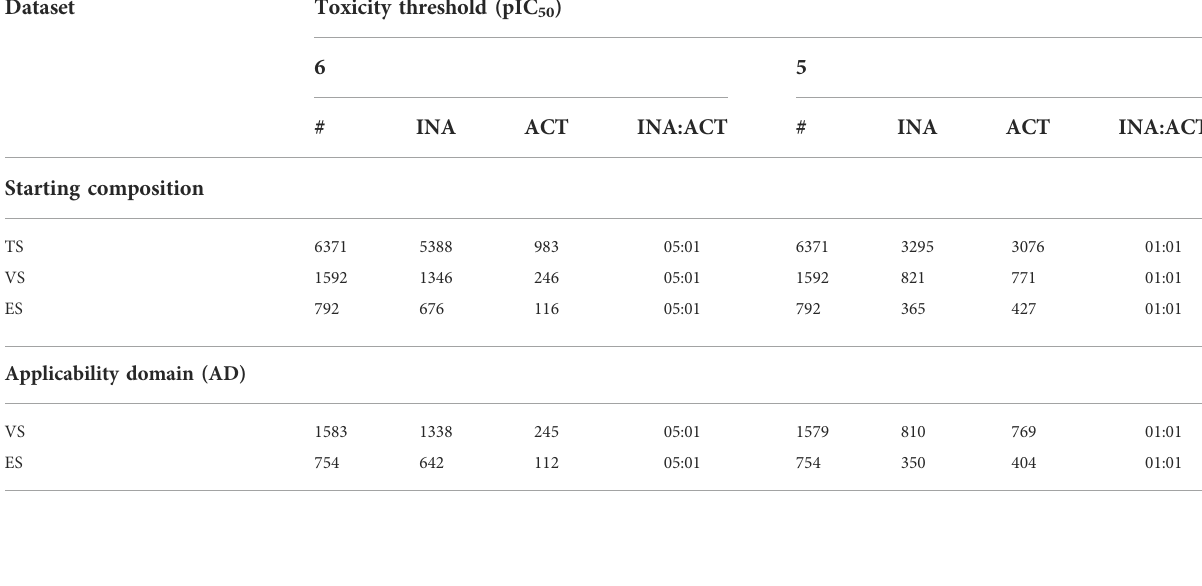
TABLE 1 Partitioning schemes before (top) and after the application of the AD at each considered toxicity threshold (bottom). For hERG-DB , the number of active and inactive chemicals and the related class distribution is reported for the training set (TS), validation set (VS), and external set (ES)andateachconsideredtoxicitythreshold.Notably,thetotalnumberofchemicals(#),thenumberof hERG blockers(ACT)and hERG non-blocker (INA) chemicals, as well as the ratio between nonblockers and blockers are shown.